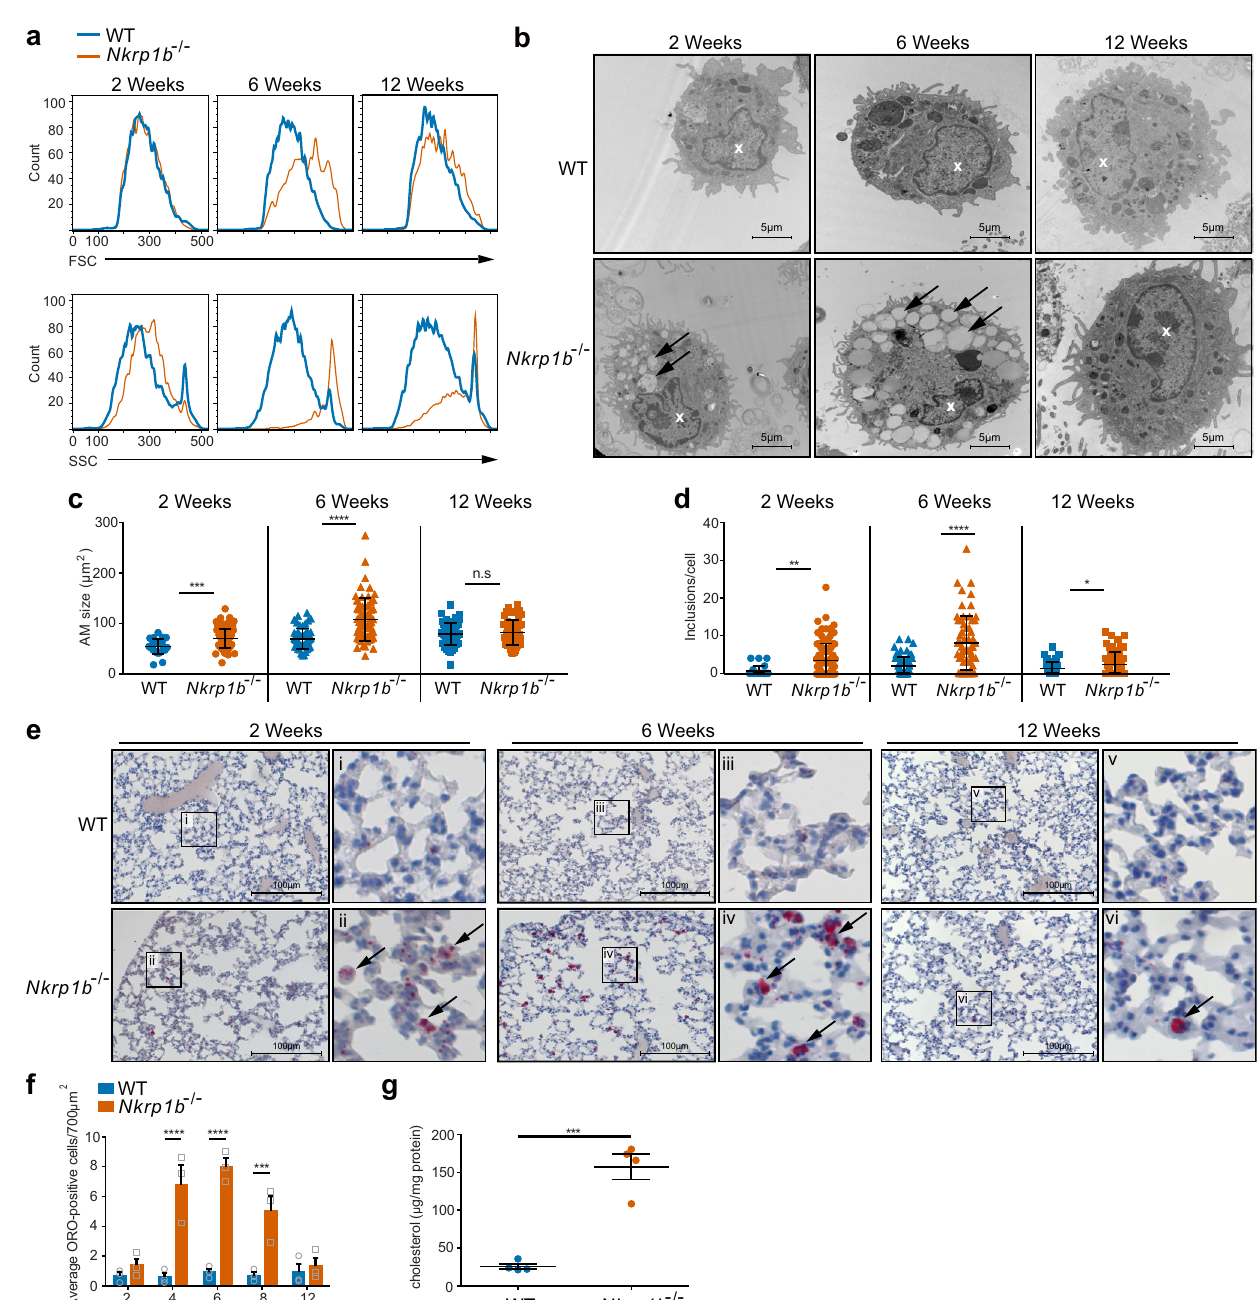
Fig. 3 | Nkrp1b − / − AM accumulate intracellular lipids over time. a FSC and SSC pro fi les of AM isolated from WT and Nkrp1b − / − mice at 2, 6, and 12 weeks of age. b Images of AM as seen by TEM isolated from WT and Nkrp1b − / − mice at 2, 6, and 12 weeks of age. Images are representative of three independent experiments. Inclusions are highlighted by arrows; the nucleus is highlighted with a white “ x ” . c and d Quanti fi cations of AM surface area and a number of electron-poor inclu- sions,respectively,asseenbyTEM.AMisolatedfrommiceaged2,6,and 12weeks. Data presented as mean±SEM. Statistics in c and d were determined by an unpaired, two-tailed Student ’ s t -test where * p <0.05, ** p <0.01, *** p <0.001, and **** p <0.0001. n =3 with 55 AM examined per experiment. e Lung sections stained with ORO obtained from WT and Nkrp1b − / − mice 2, 6, and 12 weeks of age at ×20 transcriptional pro fi le of Nkrp1b − / − AM showed altered expres- sion of genes that encode well-characterized components of lipid processing and ef fl ux, such as ABCA1, ABCG1, and DAG- kinases, as well as lipases such as LPCAT2 and PNPLA2 (Fig. 5c).